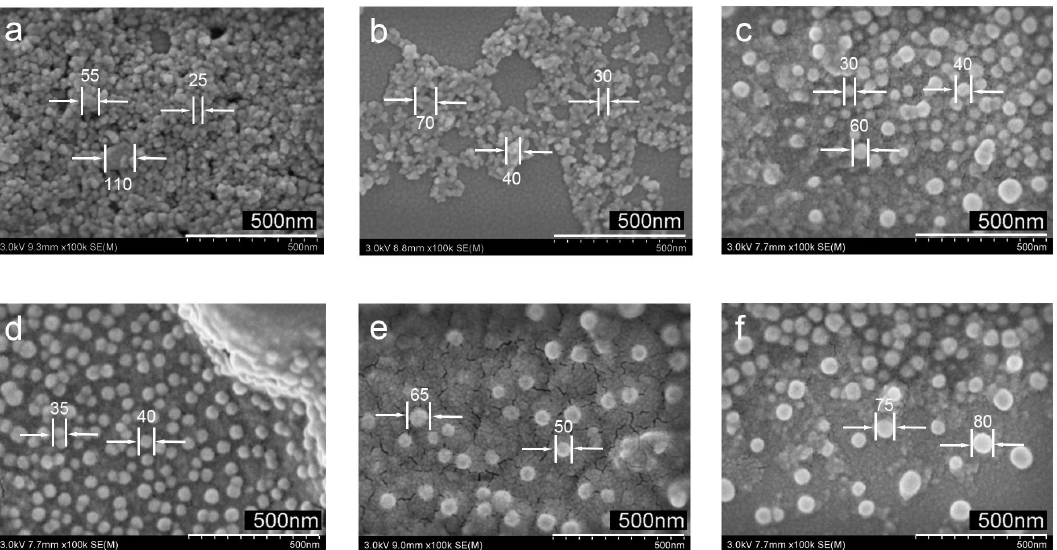
Figure 1. SEM images of TiO 2 nanoparticles (NPs) with different molars of polyamide network polymers (PNP): 0 mol ( a ), 0.25 mol ( b ), 0.5 mol ( c ), 1 mol ( d ), 2 mol ( e ) and 3.125 mol ( f ),